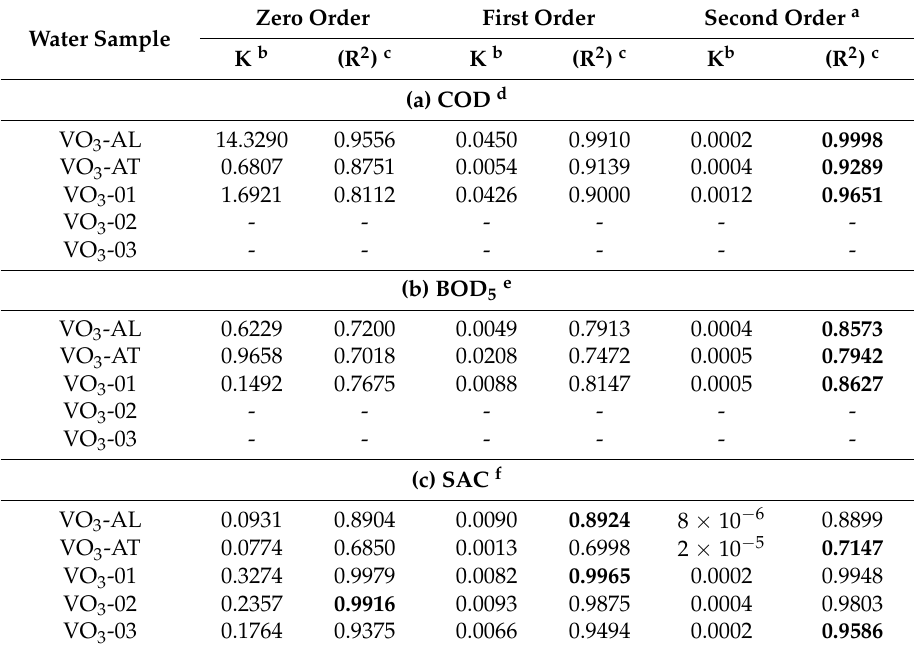
Table 4. Kinetic constants and their respective coefficients of determination for different reaction